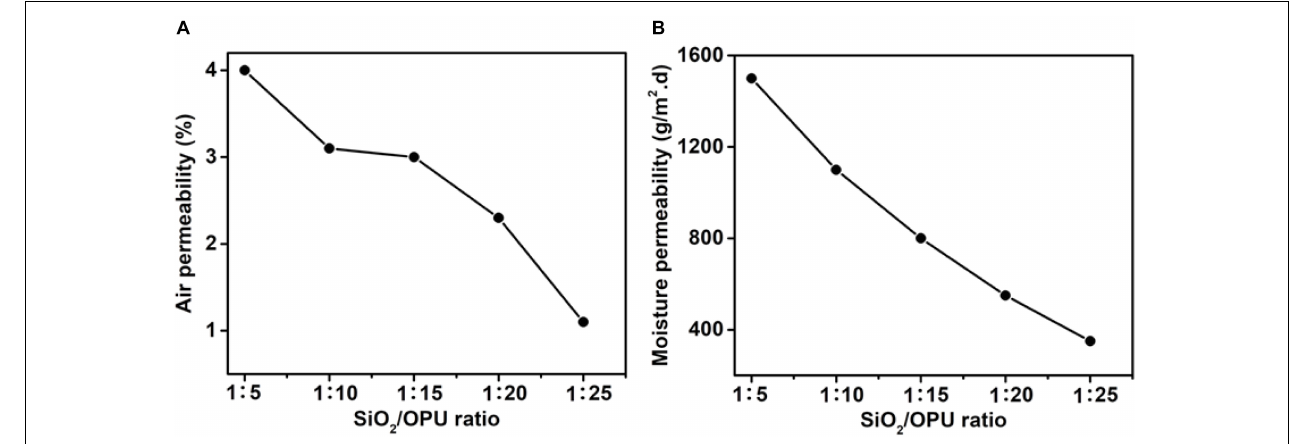
FIGURE 6 | Air permeability (A) and moisture permeability (B) of OPU/SiO 2 aerogel.